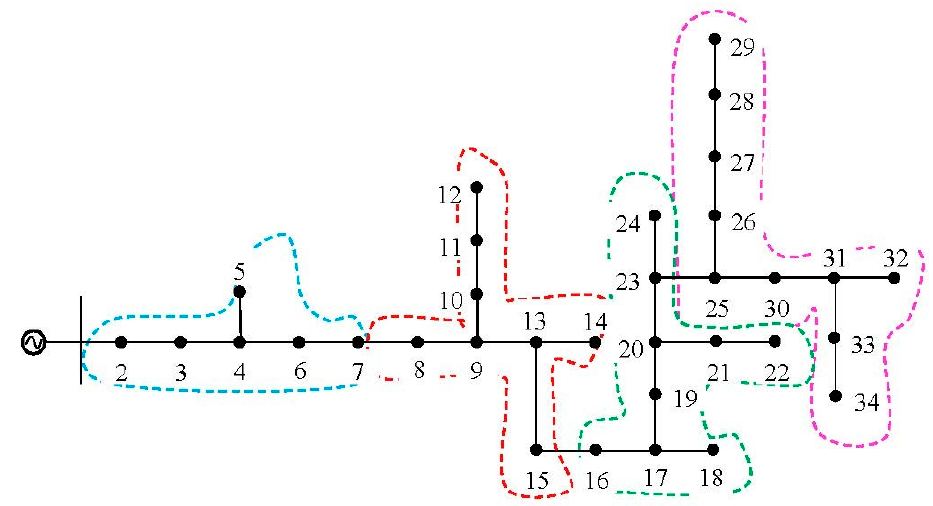
Figure 8. Network zoning to 4 microgrids. Which each zone in separated with different colors.